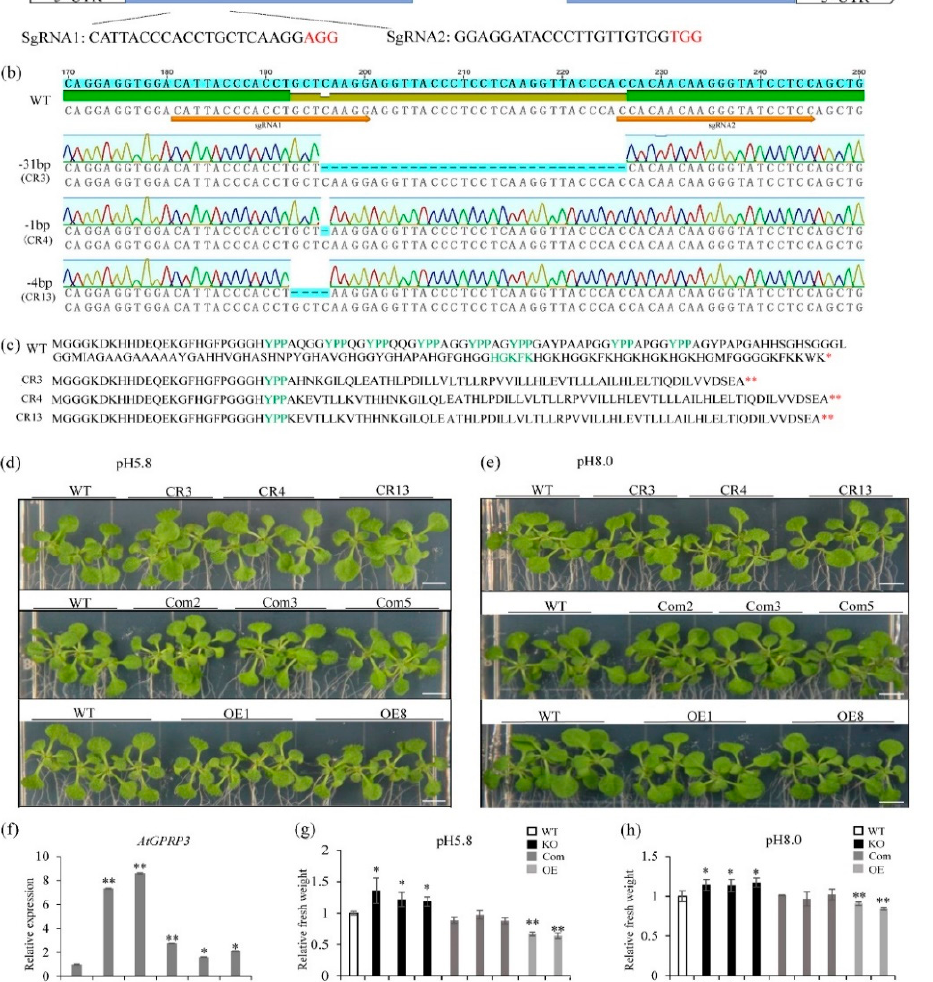
Figure 3. Creation of atgprp3 knockout mutants by CRISPR / Cas9 and impact of modification of AtGPRP3 expression on seedling growth. ( a ) CRISPR target sites of AtGPRP3 . Untranslated regions